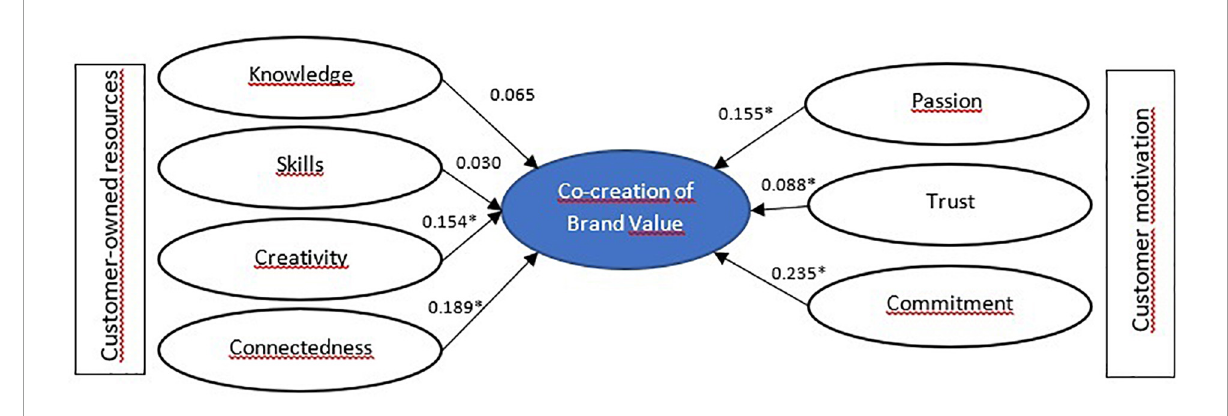
FIGURE5 Model estimation for brand value co-creator customers—Segment 4. ∗ p <